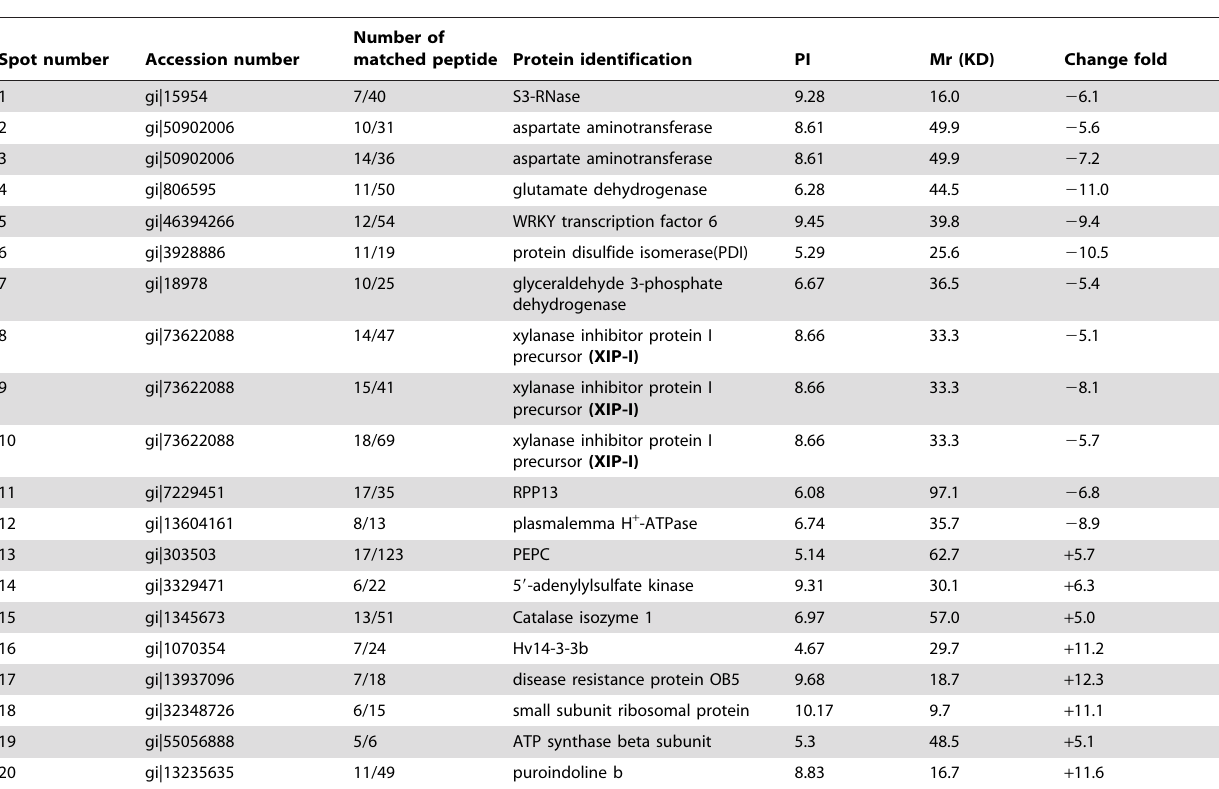
Table 2. The identification of the differential proteins in mature seeds.